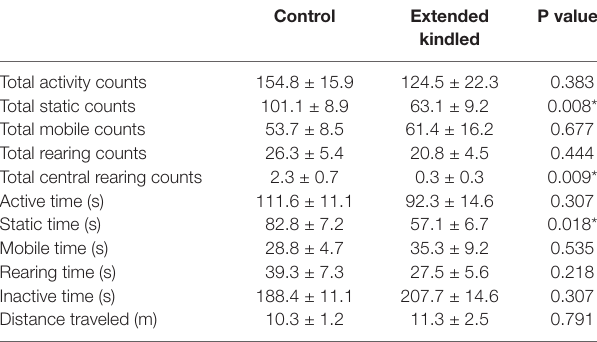
TABLE 1 | Measures of the open field